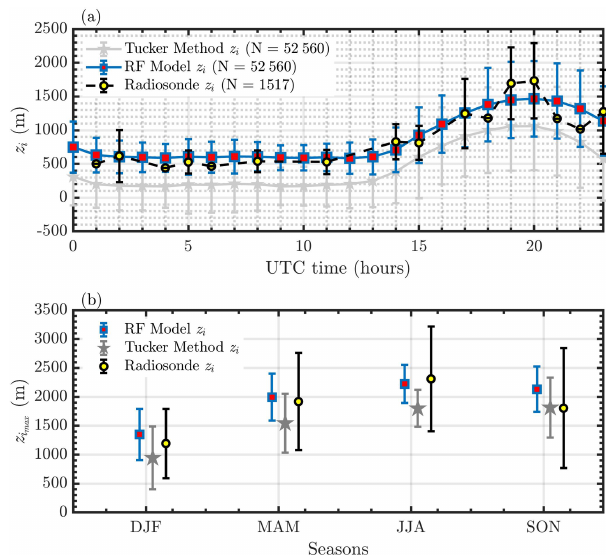
Figure 8. (a) Hourly averaged z i estimates at the SGP central fa- cility for 2019 from RF, the Tucker method, and radiosondes. Total number of samples ( N ) for each dataset is also shown in the legend. (b) Daily daytime maximum z i estimates for four seasons (DJF, MAM, JJA, SON) from RF, radiosonde, and the Tucker method. The bars in both plots represent 1 standard deviation.